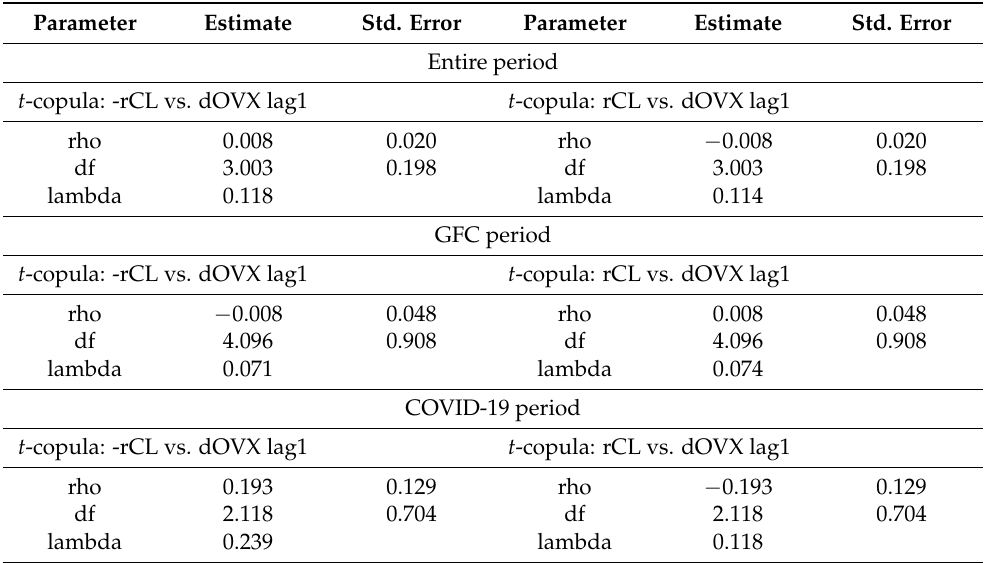
Table 2. Copula parameters and tail dependence coefficient for Crude Oil Future Contract returns (rCL) and one-day lagged changes in the CBOE Crude Oil Volatility Index (dOVX) in the entire period and